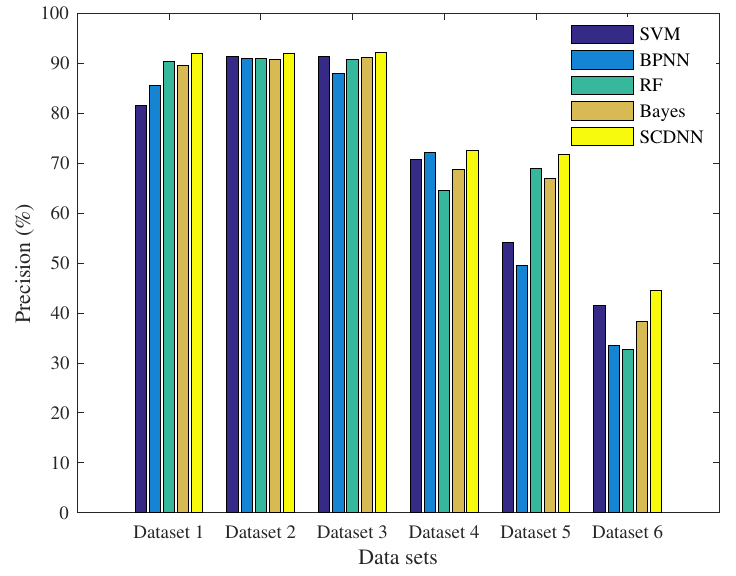
Figure 8. Average precision histograms for the five models compared between the six